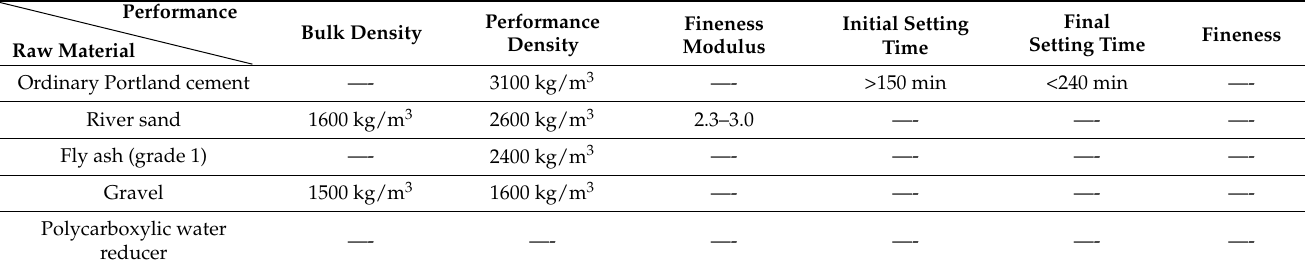
Table 1. Performance index of each raw material.